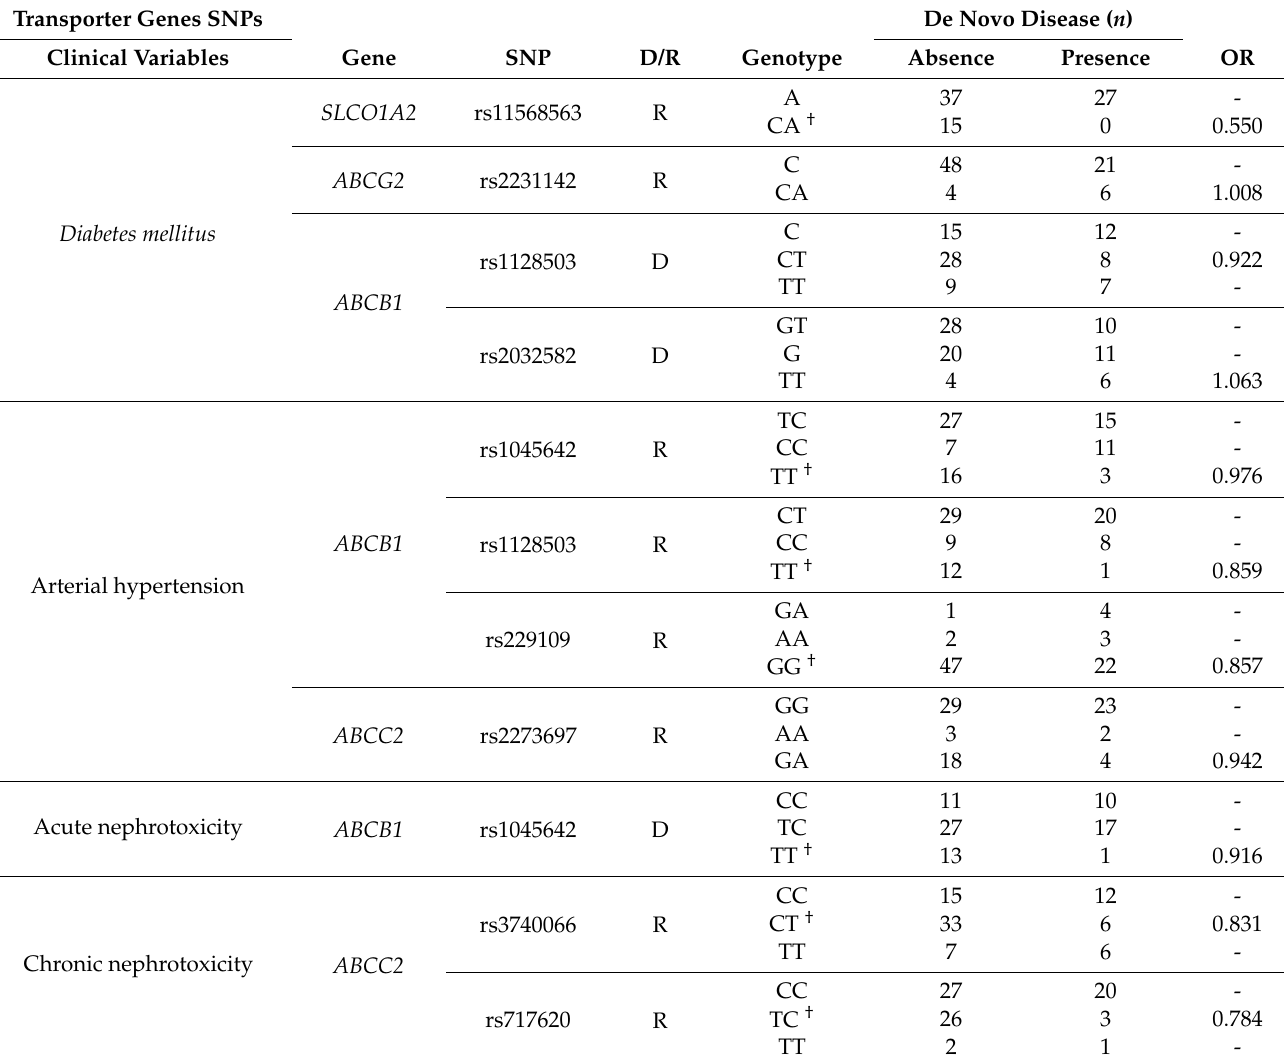
Table 6. Transporter pharmacogene variants associated with clinical variables selected by multivariate logistic regression and regularized by elastic net statistical